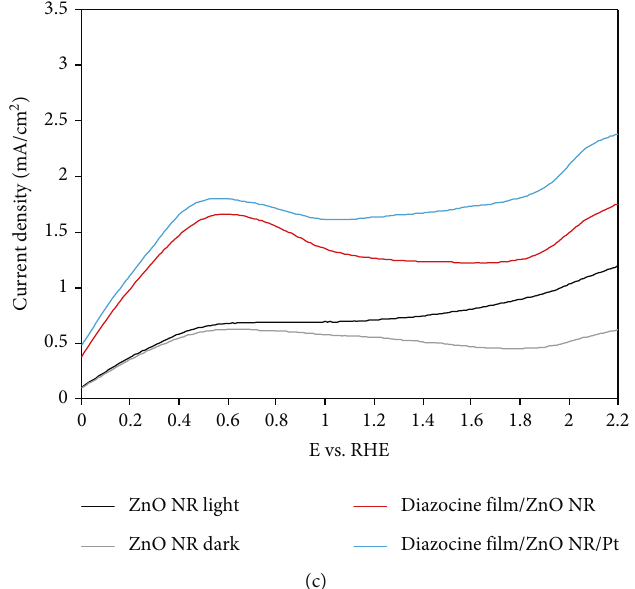
Figure 5: (a) Absorbance of ZnO NR, diazocine fi lm/ZnO NR hybrid, and diazocine fi lm/ZnO NR/Pt NP hybrid shows that diazocine fi lm enhances the absorbance of ZnO NR; (b) photoluminescence spectra of ZnO NR, diazocine fi lm, and diazocine fi lm/ZnO NR hybrid excited by 266nm laser; and (c) photocurrent J-V characteristic curves for the ZnO NR in dark and under illumination conditions, diazocine fi lm/ ZnO NR, and diazocine fi lm/ZnO NR/Pt NP